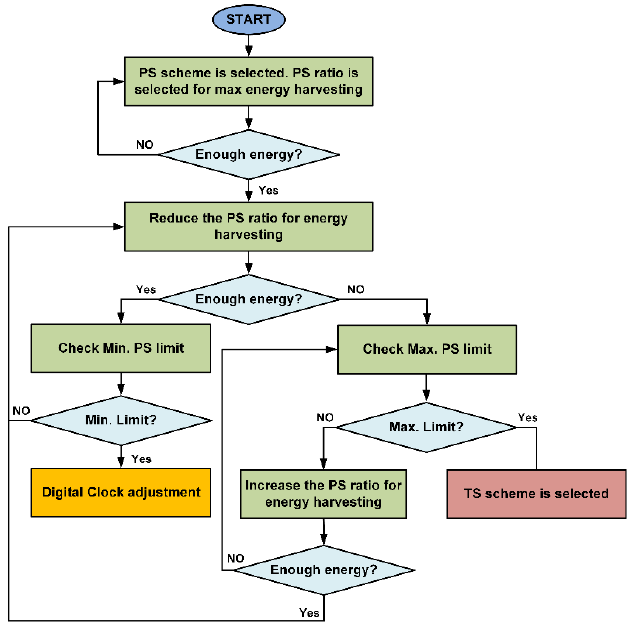
Figure 8. Flow diagram for the SWIPT transmitter during the PS scheme.